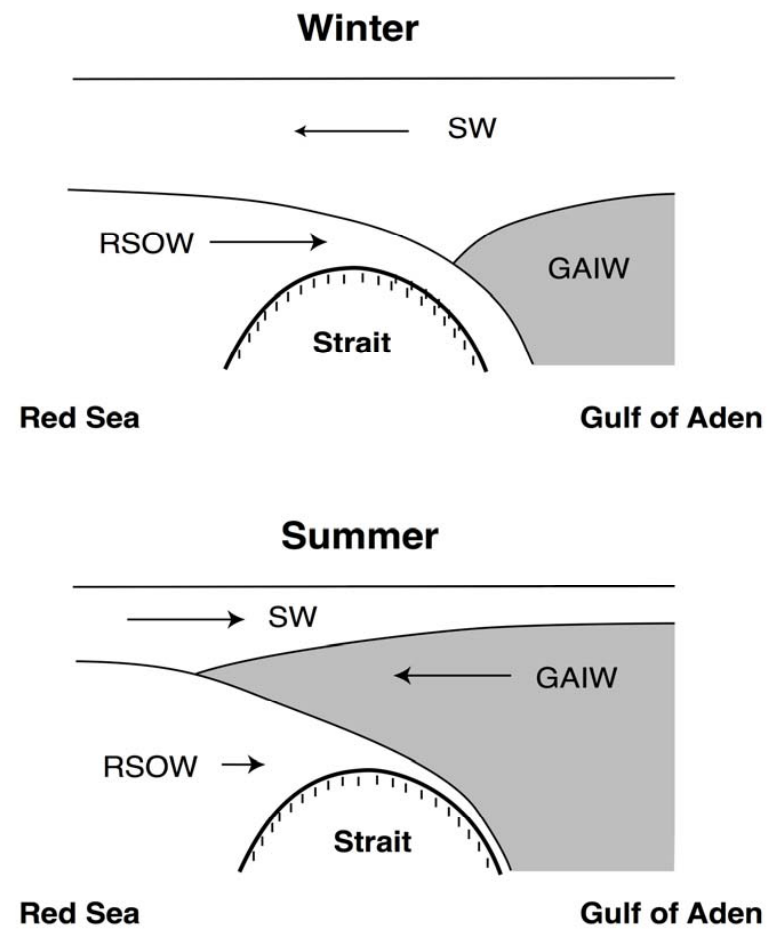
Figure 10. Sketch of the two circulation patterns in the Strait of Bab El Mandeb in the southern Red Sea. ( Top ) winter circulation. ( Bottom ) summer circulation. SW: surface water; GAIW: Gulf of Aden intermediate water; RSOW: Red Sea outflow water. (This figure is taken from [2] and used with permission).